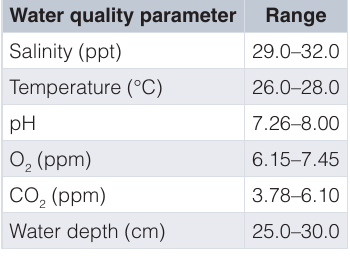
Table 6. The water quality of the maintenance media for female broodstock blue swimming crabs, P. pelagicus (Linnaeus, 1758), with a formulated diet of vitamin E supplementation at different